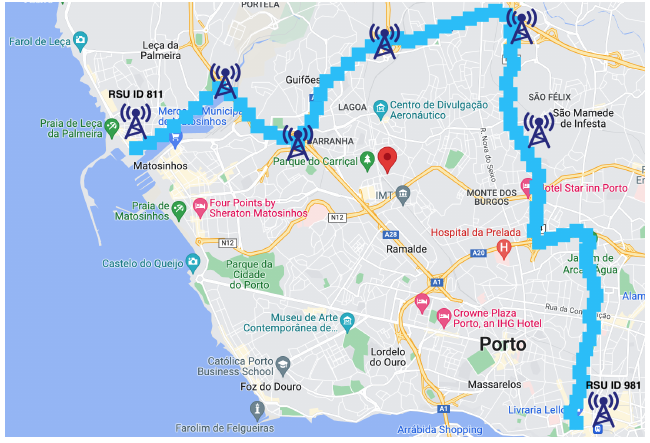
Figure 3. Partitioned trajectory between two locations for OBU-ID =